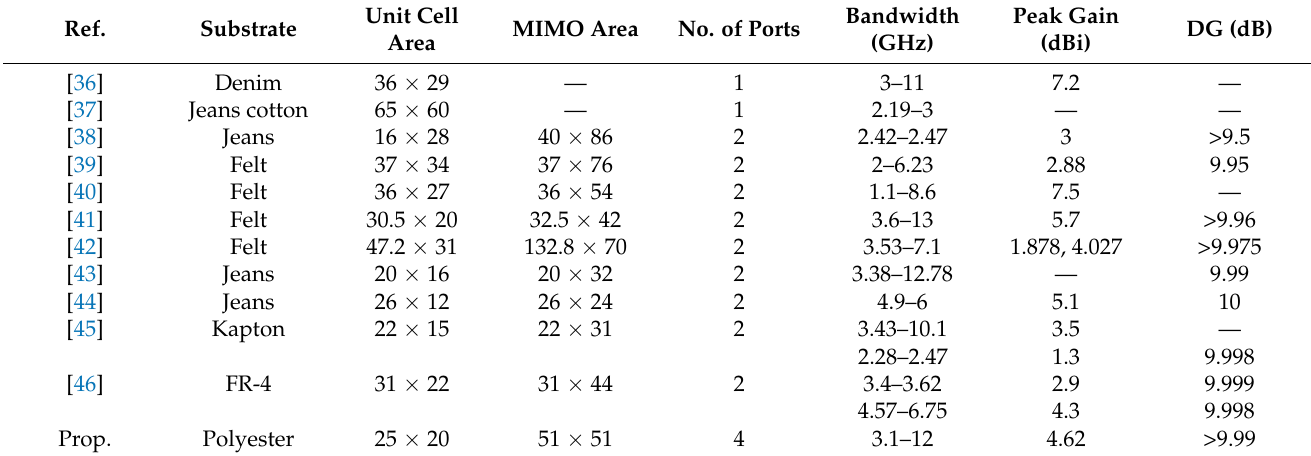
Table 3. Comparison of the proposed antenna with the previously published antenna designs.